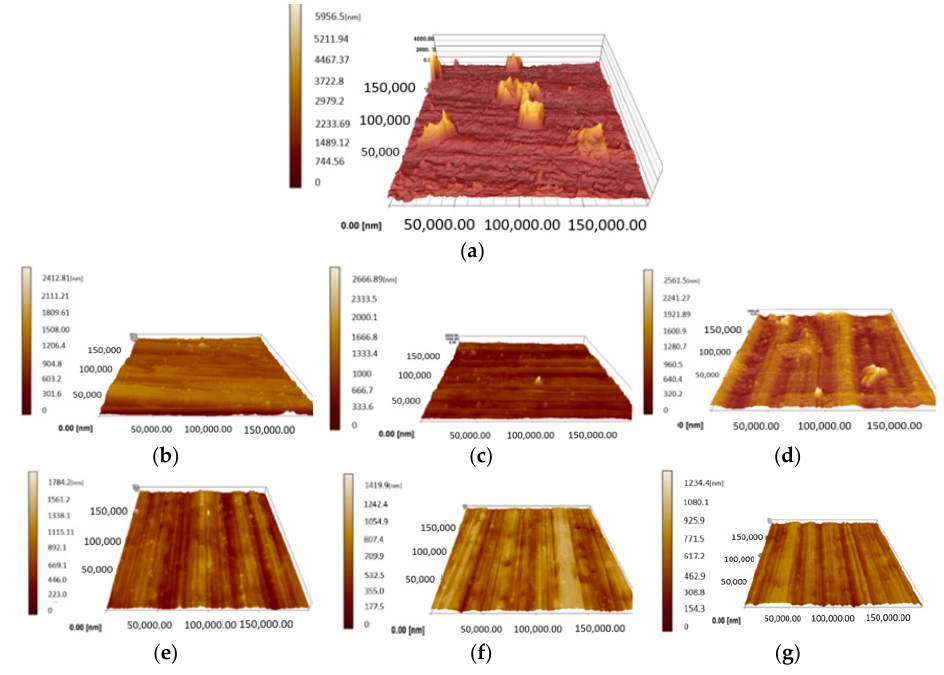
Figure 8. Three-dimensional surface topographies of the surface with different amplitudes: ( a ) original specimen, ( b ) 0.5 μ m, ( c ) 1.00 μ m, ( d ) 1.5 μ m, ( e ) 2 μ m, ( f ) 3.5 μ m, ( g ) 6 μ m.